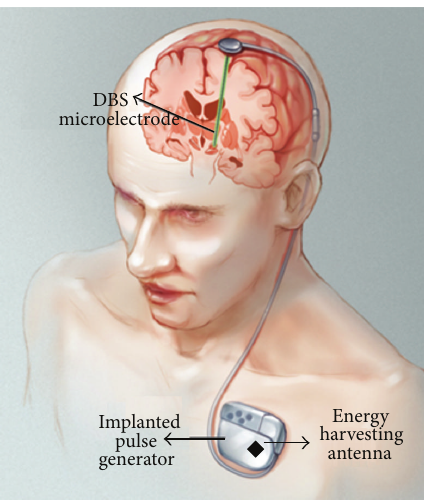
Figure 1: A typical DBS system with an energy harvesting antenna inside the implanted pulse generator